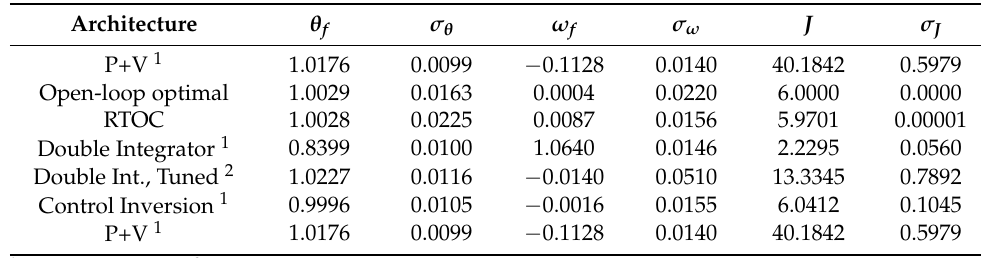
Table 1. Numerical results of Monte Carlo simulations, N = 1000. σ refers to the standard deviation of a quantity. All other numerical results represent the mean over all simulations.